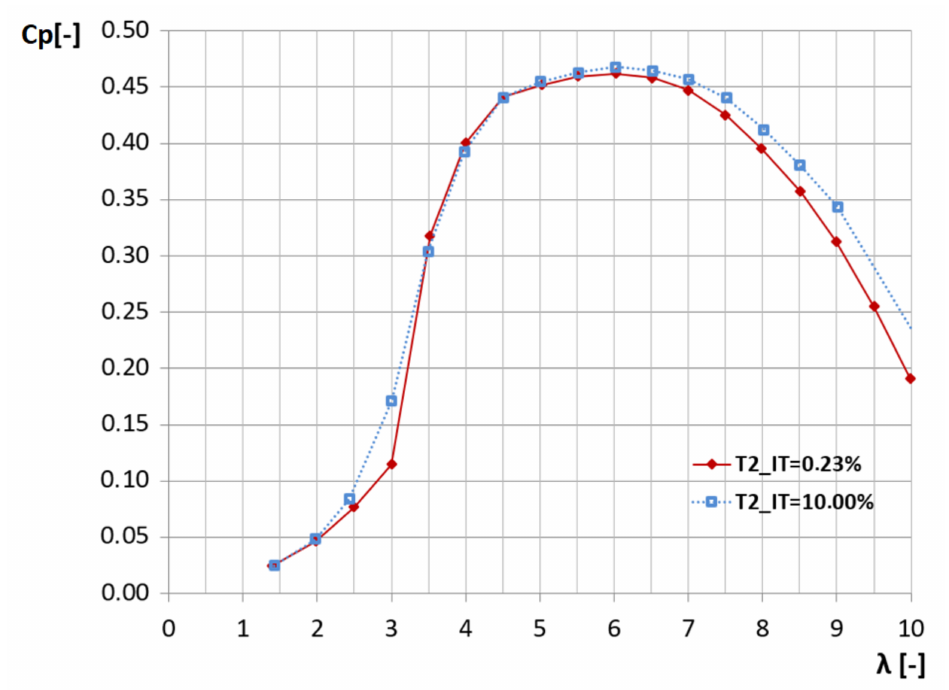
Figure 7. Power coefficient curves for T2 turbine at low inlet turbulence intensity (solid red) and high inlet turbulence intensity (dashed